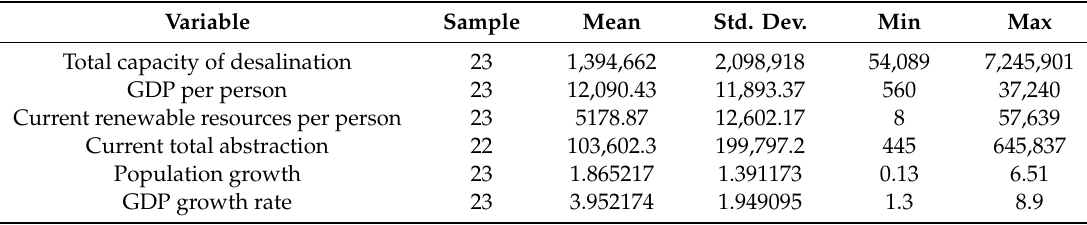
Table 2. Basic descriptive statistics of the variables.